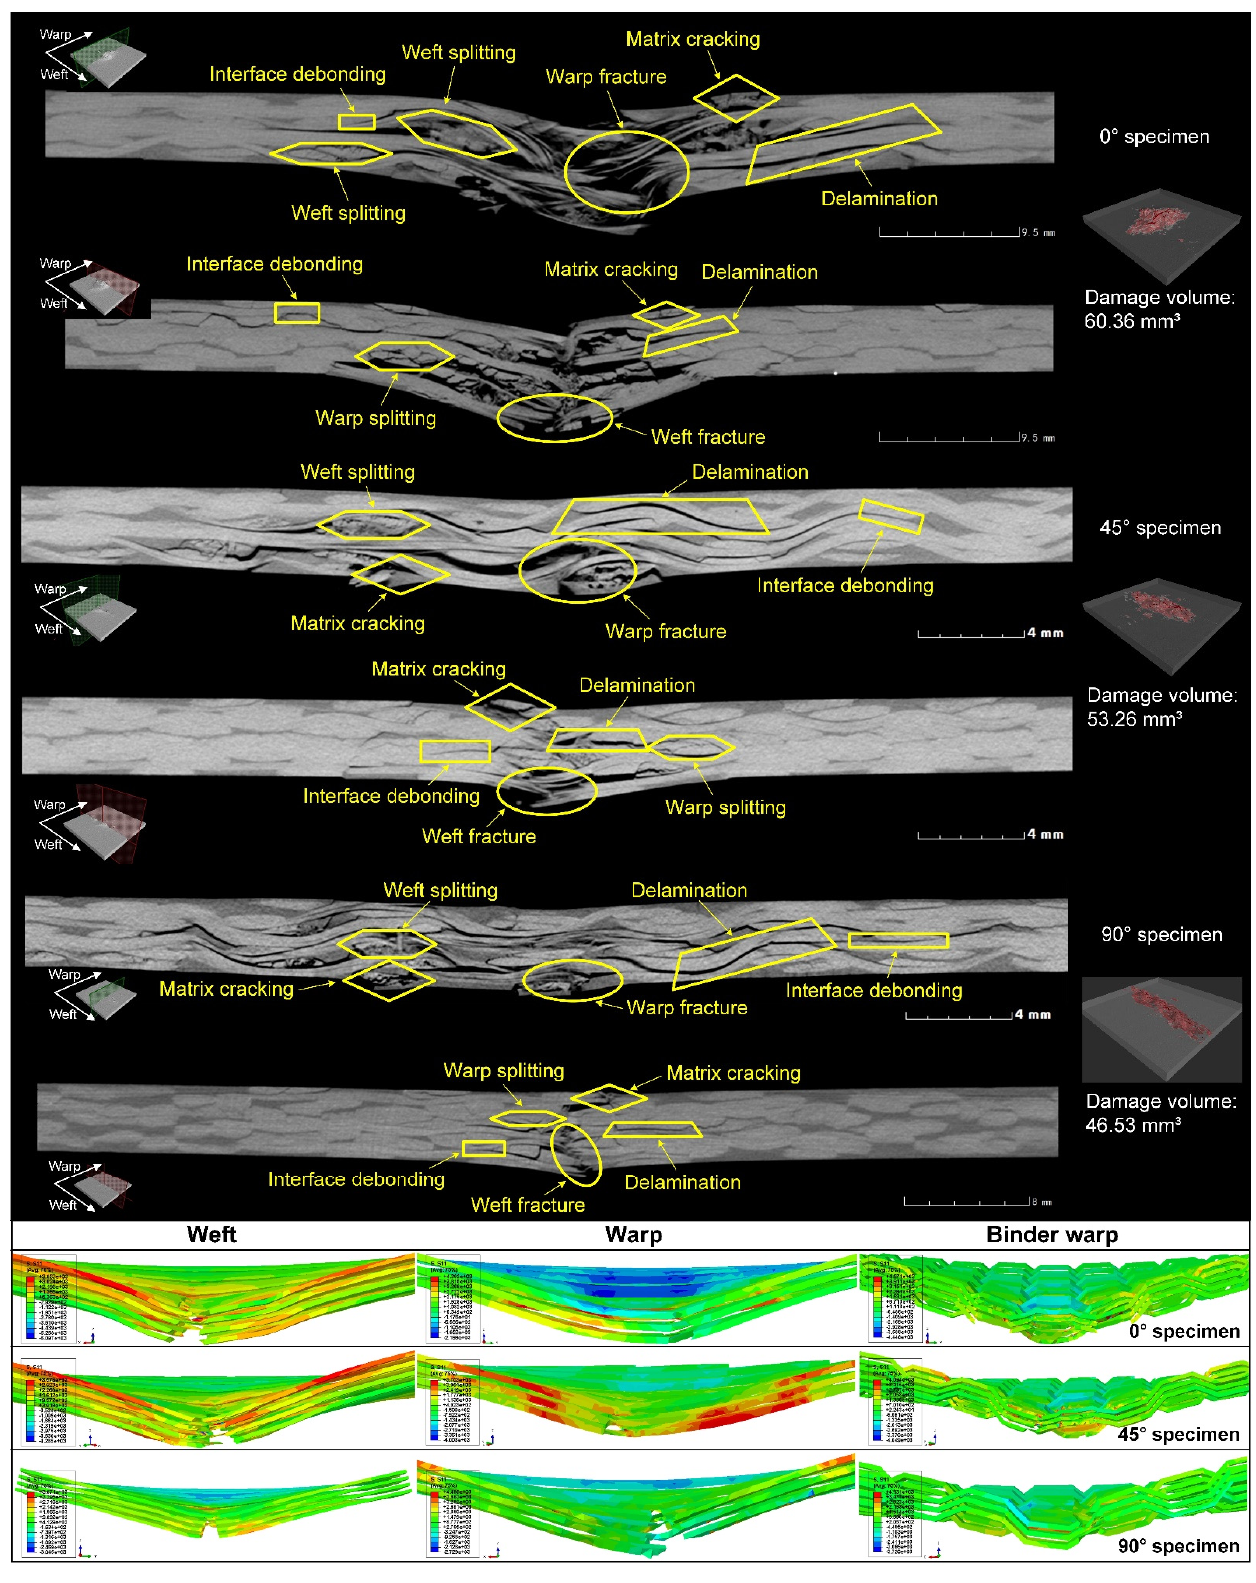
Figure 9. Internal damage morphology and axial stress distribution of the component yarns under 47.6 J of impact energy.